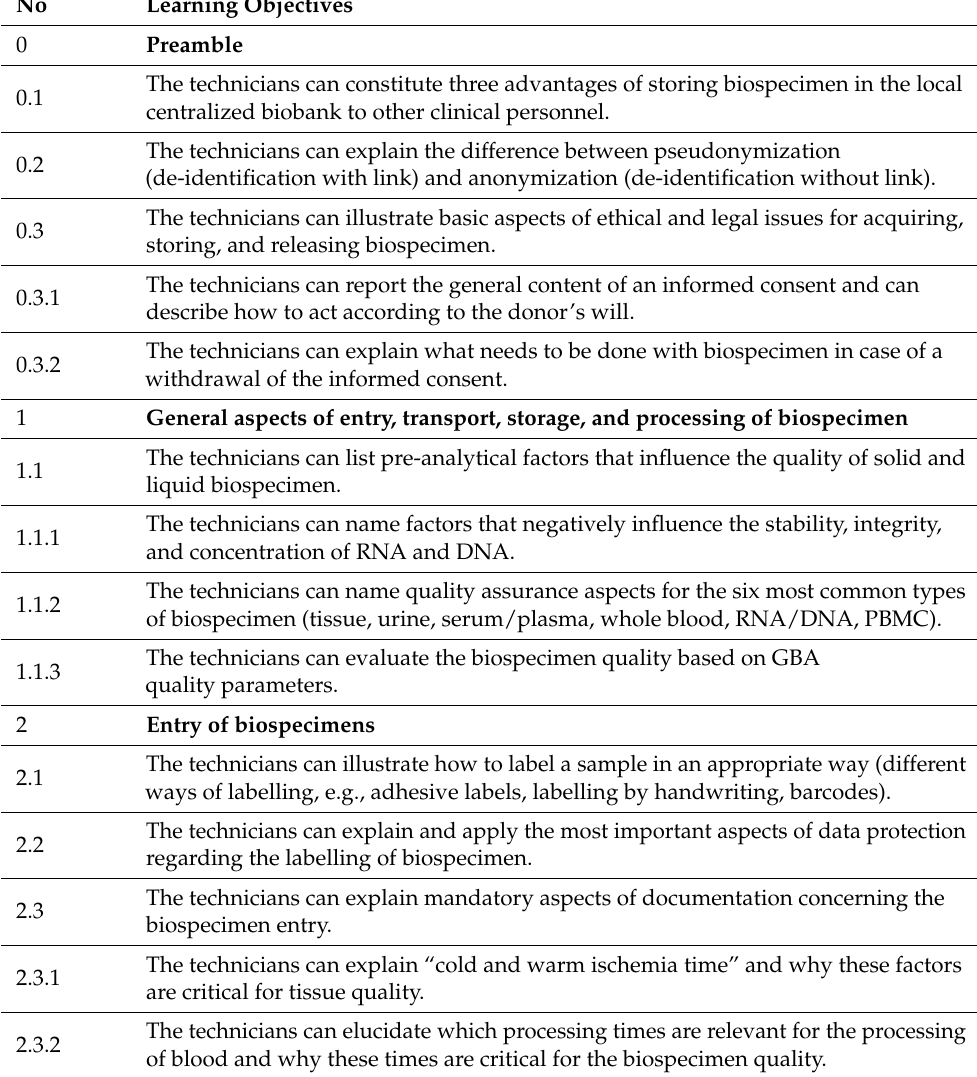
Table 1. List of the 41 learning objectives, sorted according to nine main biobanking